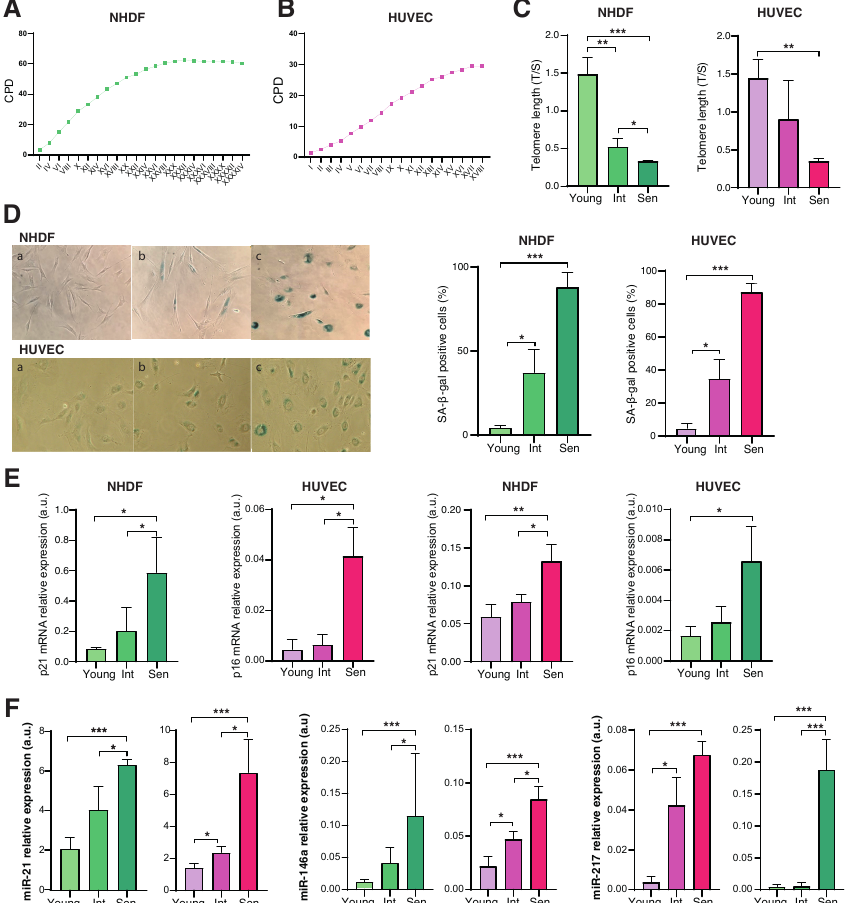
Figure 1. Characterization of replicative senescence of NHDFs and HUVECs. Growth curve showing cumulative population doublings (CPDs) of NHDFs ( A ) and HUVECs ( B ) undergoing replicative senescence (X axis: cell passages). ( C ) Telomere length was analysed by Real Time-PCR calculated as telomere/single copy gene ratio (T/S). ( D ) Representative images of SA- β -Gal in young (a), in an intermediate passage (b) and in senescent (c) NHDFs and HUVECs. ( E ) p21 and p16 mRNA expression evaluated by RT-PCR. β -actin was used as internal control. ( F ) miR-21, miR-146a and miR-217 relative expression evaluated by RT-PCR. RNU44 was used as internal control. * p < 0.05; ** p < 0.01; *** p < 0.001 for paired t